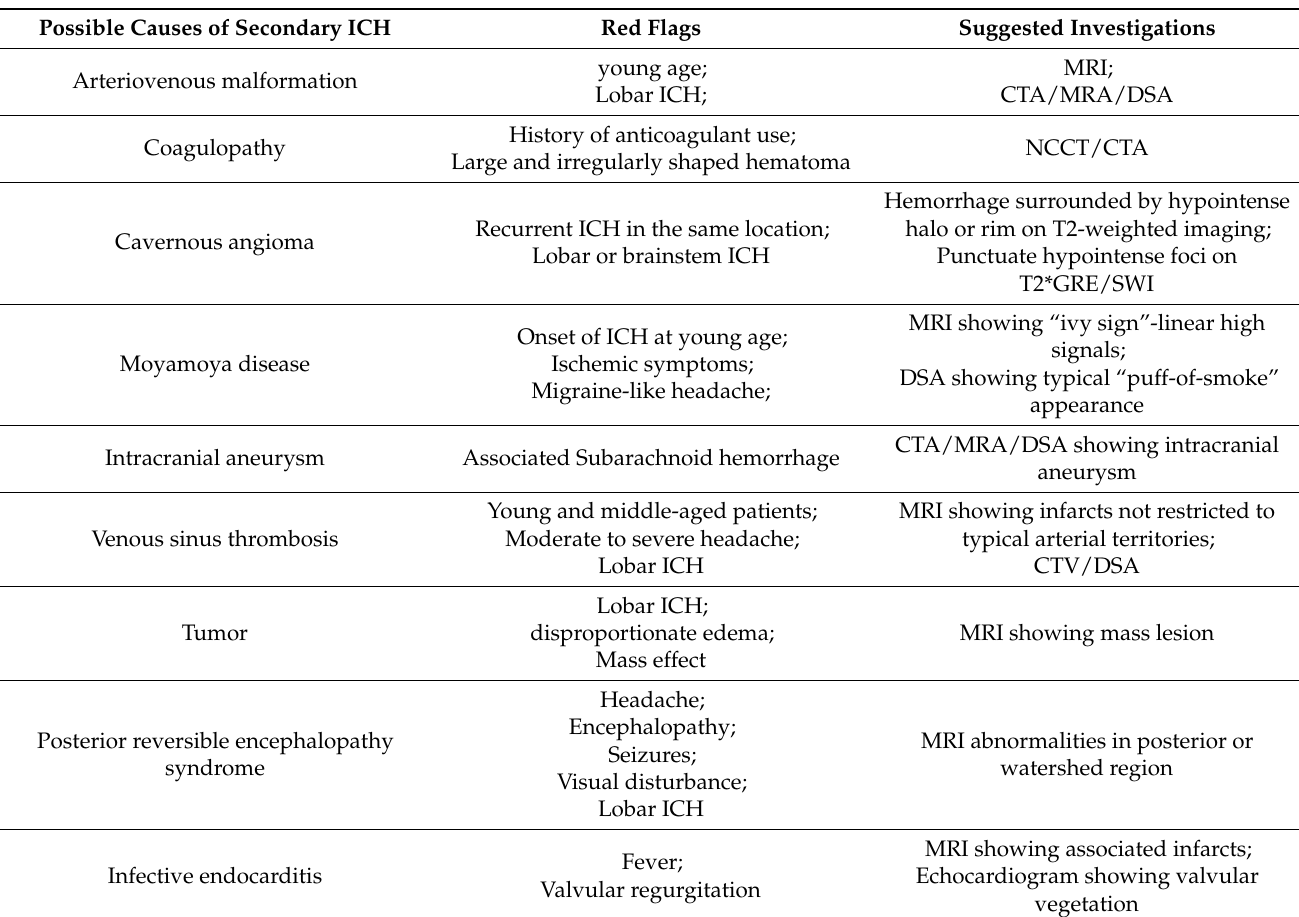
Table 2. Red flags for secondary